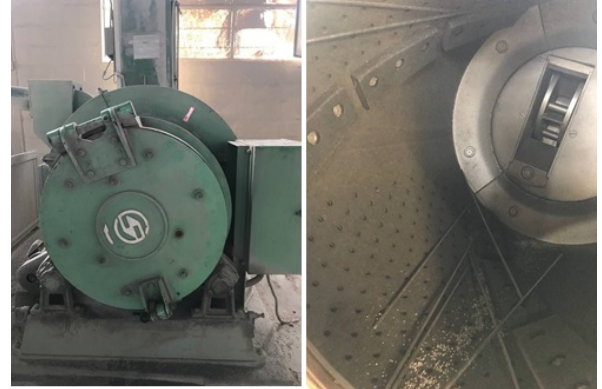
Figure 1: Shot peening machine